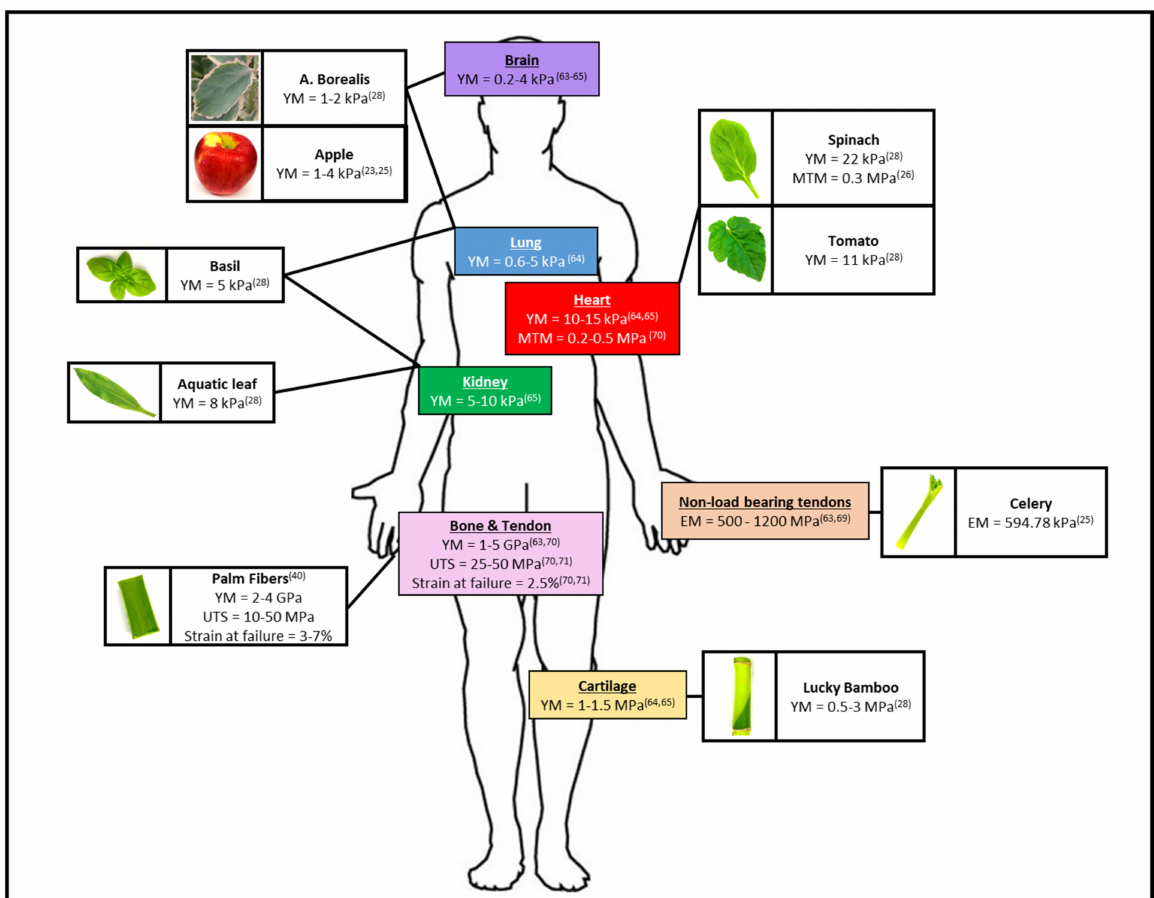
Figure 7. Correlation of mechanical properties between decellularized plant-based scaffold and human